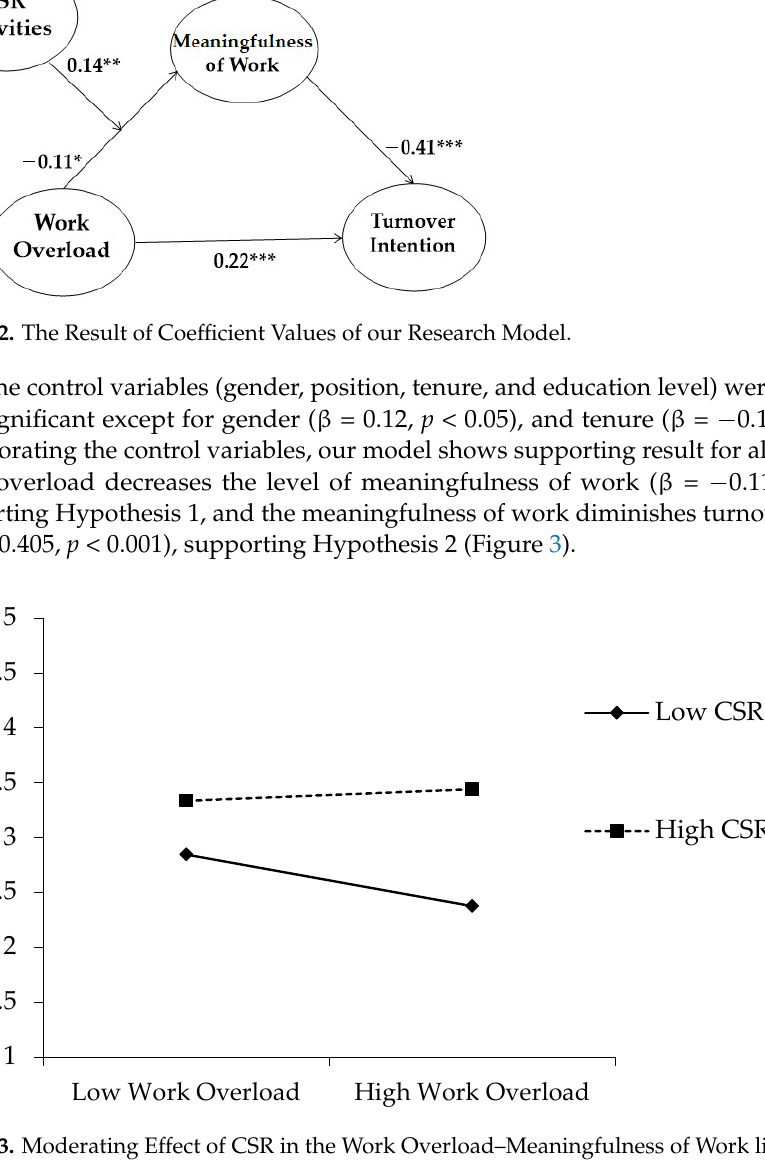
Table 3. Direct, Indirect, and Total Effects of Final Research Model.